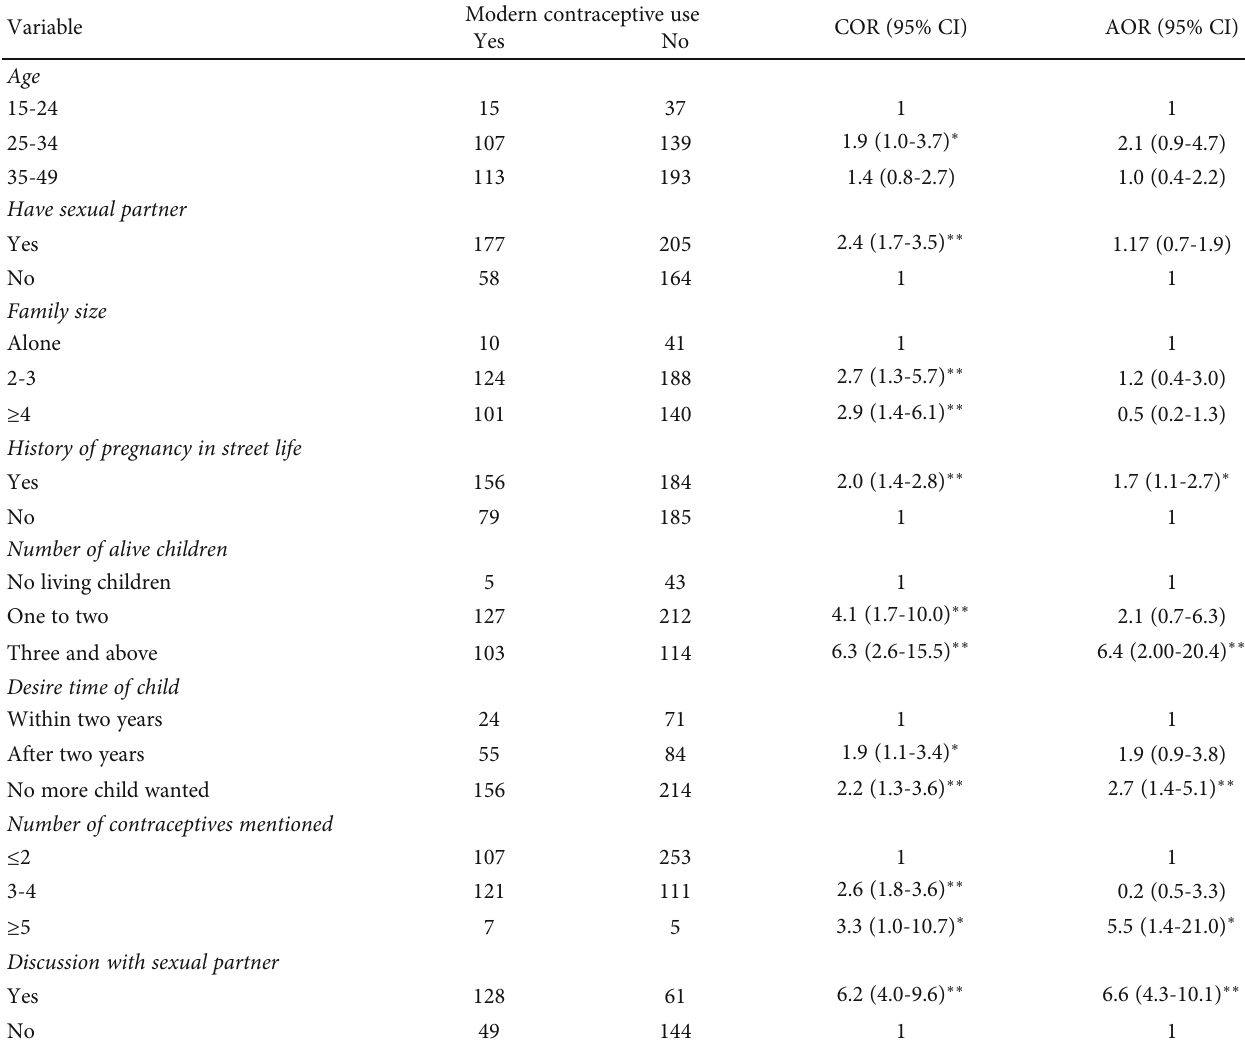
Table 3: Bivariable and multivariable analysis of factors associated with modern contraceptive utilization among street reproductive-aged women in Amhara regional state zonal towns, North West Ethiopia, 2019 ( n = 604